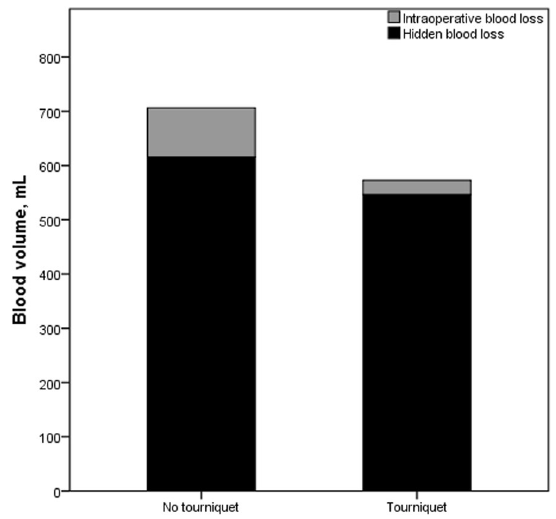
Fig. 2 Comparison of hidden blood loss ( black ) and intraoperative blood loss ( gray ) between the two groups